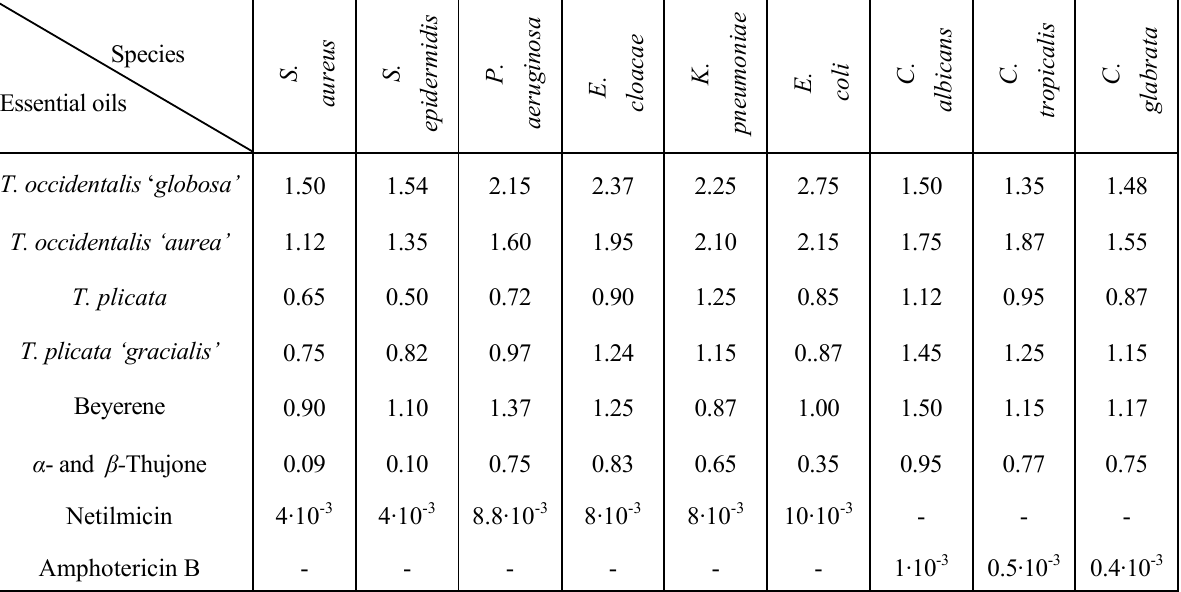
Table 3. Antimicrobial activities (MIC mg/mL) of Thuja essential oils and their main components. Species Essential